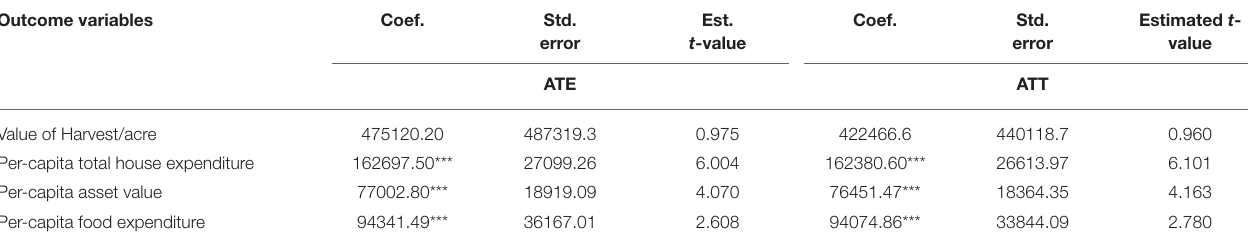
TABLE 6 | Endogenous treatment regression estimates: ATE and ATT. Outcome variables Coef. Std.